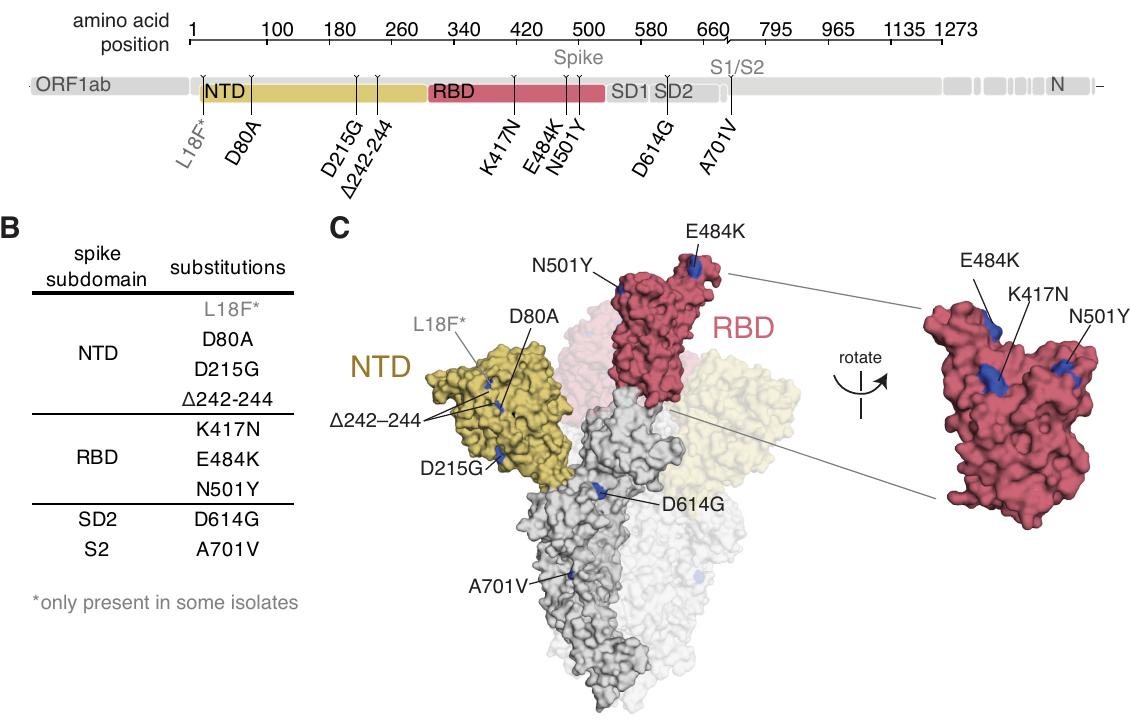
Fig 1. B.1.351 spike mutations. (A, B) Mutations in the B.1.351 spike relative to Wuhan-Hu-1 [17]. L18F is only present in some B.1.351 isolates. Visualization generated by https://covdb.stanford.edu/sierra/sars2/by-patterns/. (C) Sites where mutations occur in the spike ectodomain are highlighted in blue on the Wuhan-Hu-1 one-RBD open spike trimer (left, PDB 6ZGG) [75] or RBD (right) (PDB 6M0J) [76]. The surface of one spike monomer is shown; the other two protomers are transparent.